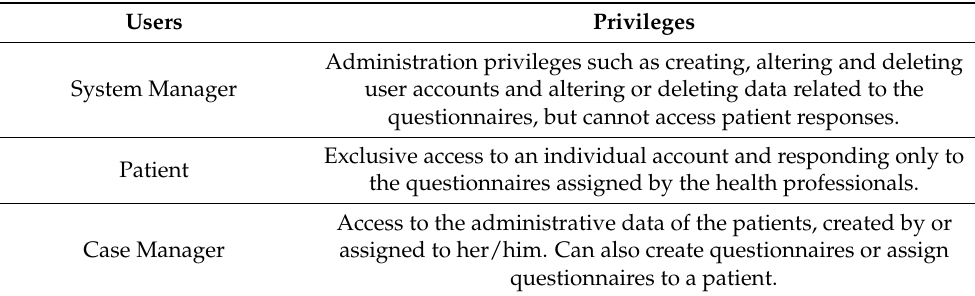
Table 2. MoodUP platform type of users and